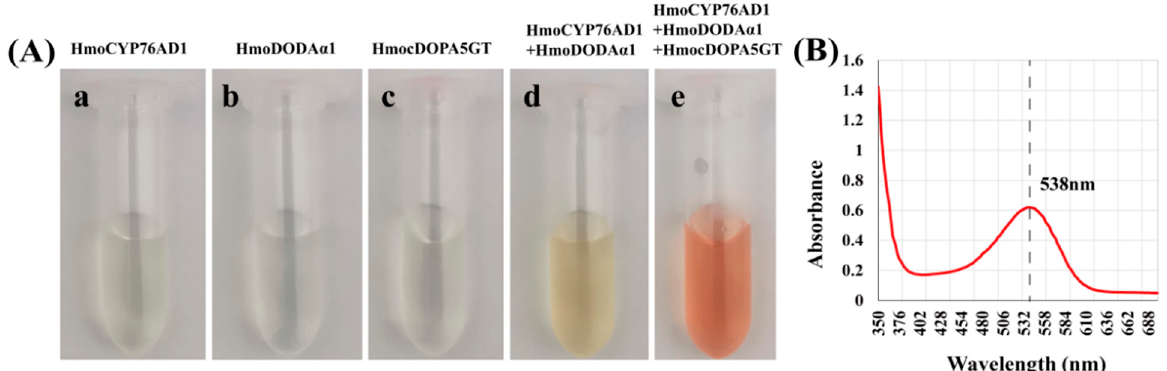
Figure 9. Recombinant expression of HmoCYP76AD1 , HmoDODA α 1 and HmocDOPA5GT in yeast. ( A ) Visual appearance of yeast medium from yeast strains. ( a – c ) The yeast strains only harboring HmoCYP76AD1 , HmoDODA α 1 or HmocDOPA5GT . ( d ) Co-expressing HmoCYP76AD1 and HmoDODA α 1 . ( e ) Co-expressing HmoCYP76AD1 , HmoDODA α 1 and HmocDOPA5GT. ( B ) Maximum absorption of the pigment.